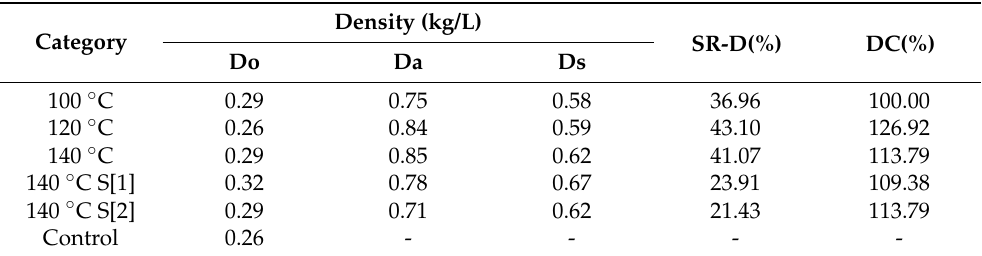
Table 3. The density of Albizia falcataria before and after densification